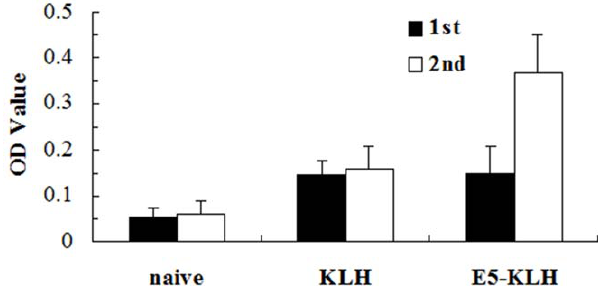
Figure 7. Anti-CE antibodies titres in mice immunized with E5 synthetic peptide. CE-binding IgG in the sera of mice (n=5) immunized twice (50 m g per mouse) with KLH conjugated E5 peptide or with KLH as a control and naı¨ve mice were detected by ELISA as described in Methods. IgG levels are shown prior to and after each immunization (1 st filled bars and 2 nd open bars). The OD value of each sample in triplicate was read 15 min after addition of substrate and the mean 6 SD was determined. Significance was determined by a two- tailed, Mann-Whitney test. (P=0.0079).